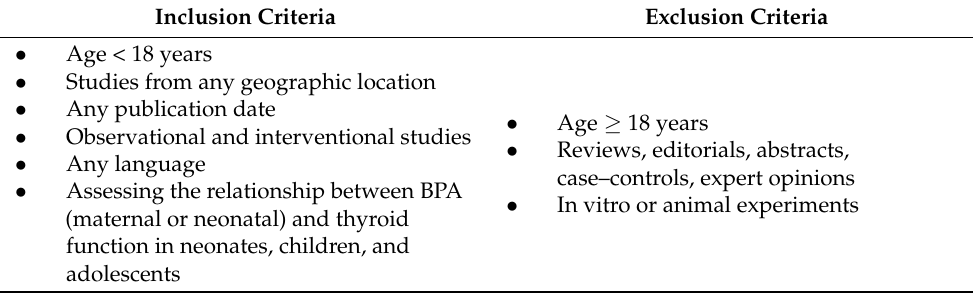
Table 1. Inclusion and exclusion